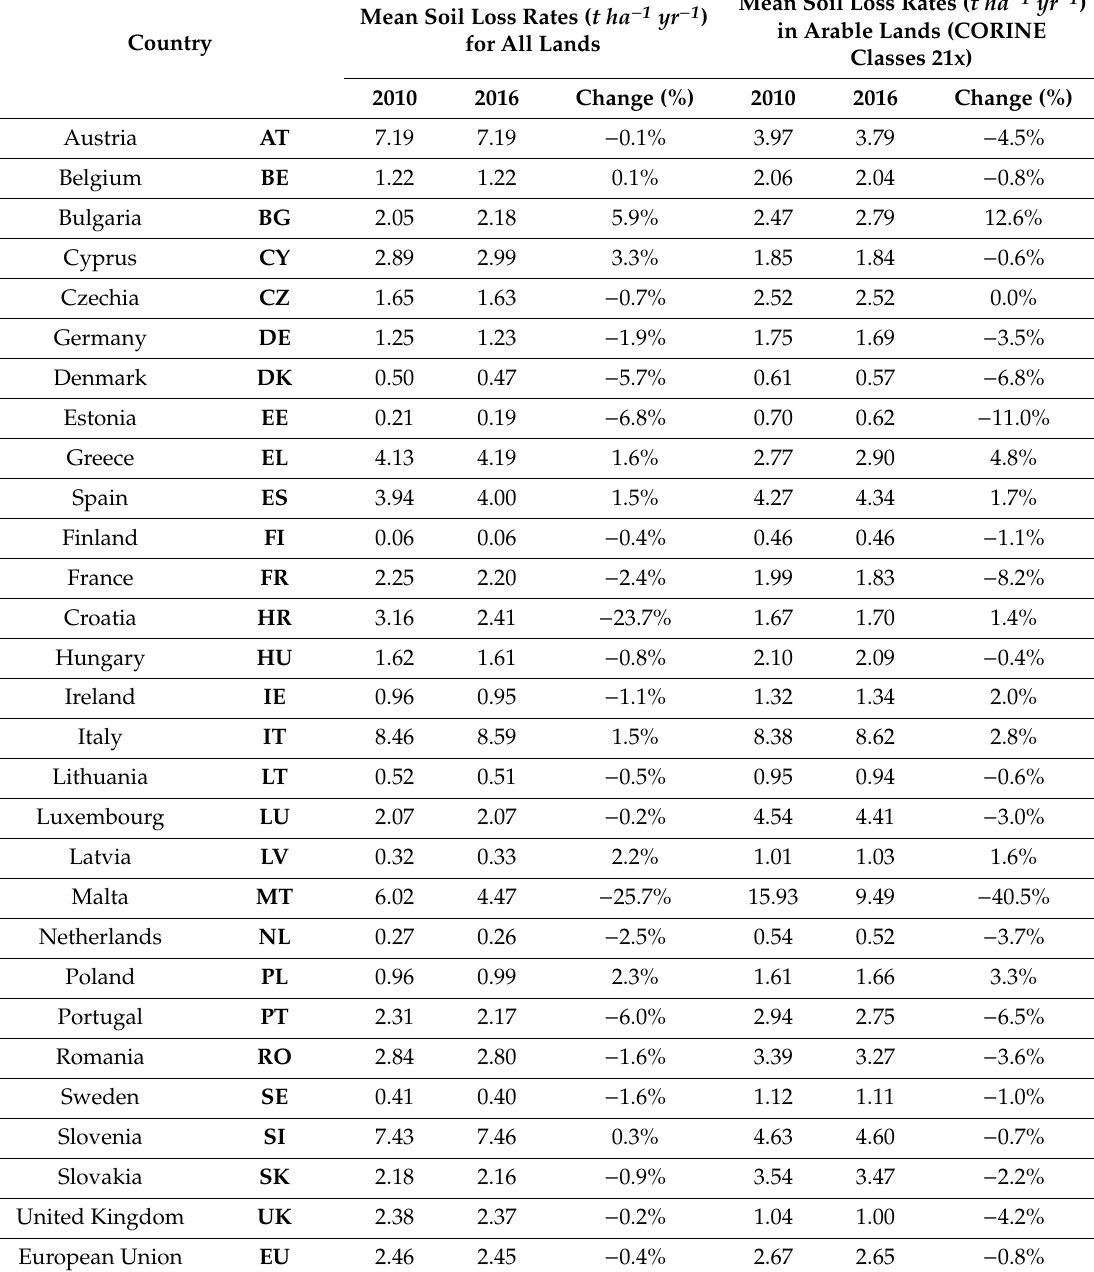
Table 2. Comparison of soil loss rates for 2010 and 2016 (all lands, arable lands).